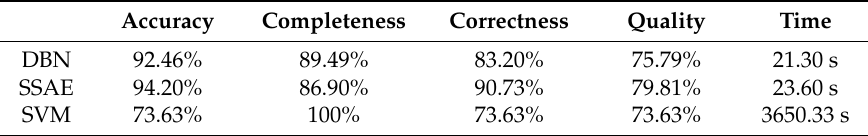
Table 5. Different methods of extraction results Area 30. Sensors 2017 , 17 , 1957